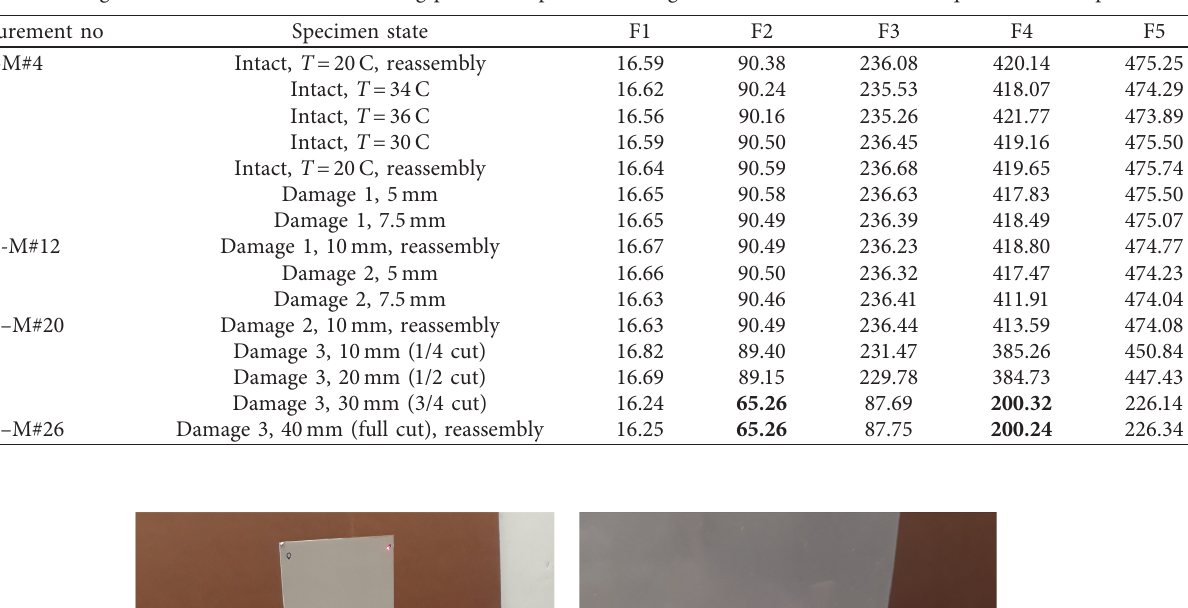
Table 3: Organization of measurements during practical experiment along with the first five natural frequencies of the plate.